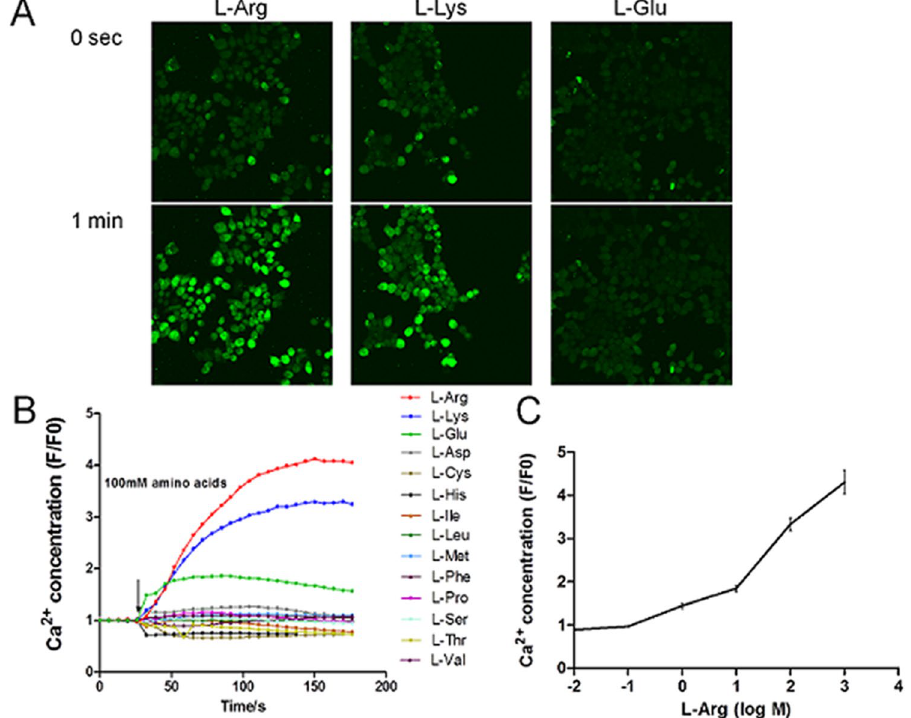
Figure 7. Responses of HEK293T cells co-expressing grass carp T1R1 and T1R3 to tastant stimuli. ( A ) Representative radiometric images of fluo-4AM-loaded HEK293T cells during the application of 100 mM L-Arg, L-Lys and L-glu. Top and bottom panels show the cell images that were obtained 0 s and 1 min after stimulation, respectively. ( B ) The quantification of responses of grass carp T1R1- and T1R3-transfected cells. Amino acids were used at 100 mM. ( C ) Dose-dependent responses of grass carp T1R1 and T1R3 to L-Arg. Responses were normalized to the mean response before tastant